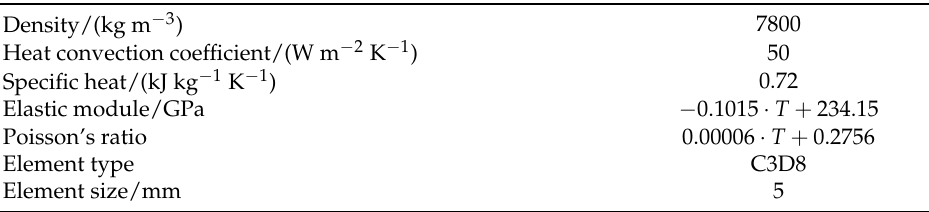
Table 2. Material parameters of experimental steel.